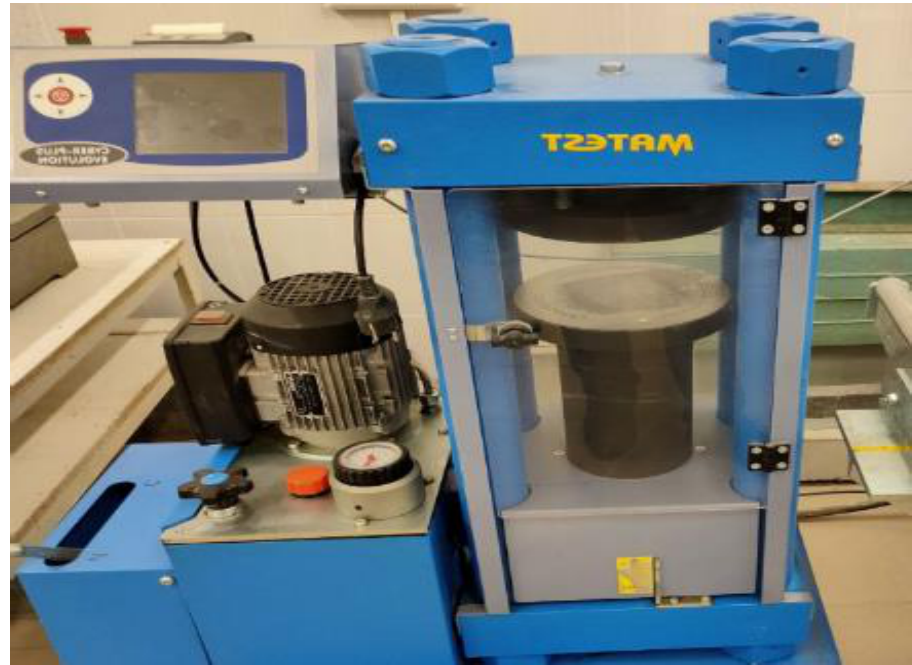
Figure 6. The compression test machine (C025N Matest Machine).